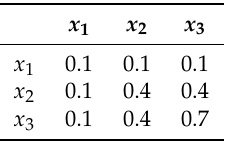
Table 4. Values of the function h min